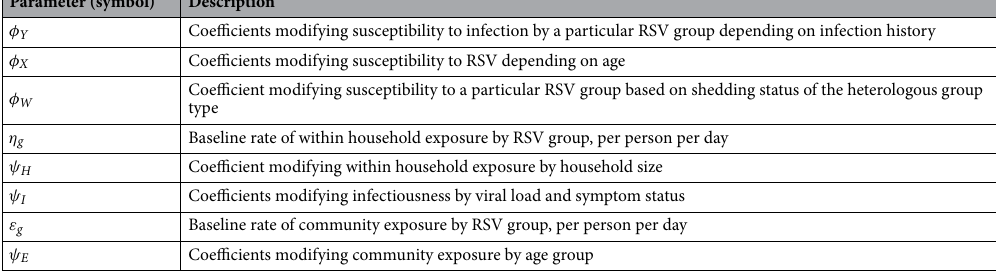
Table 2. Model parameters and their